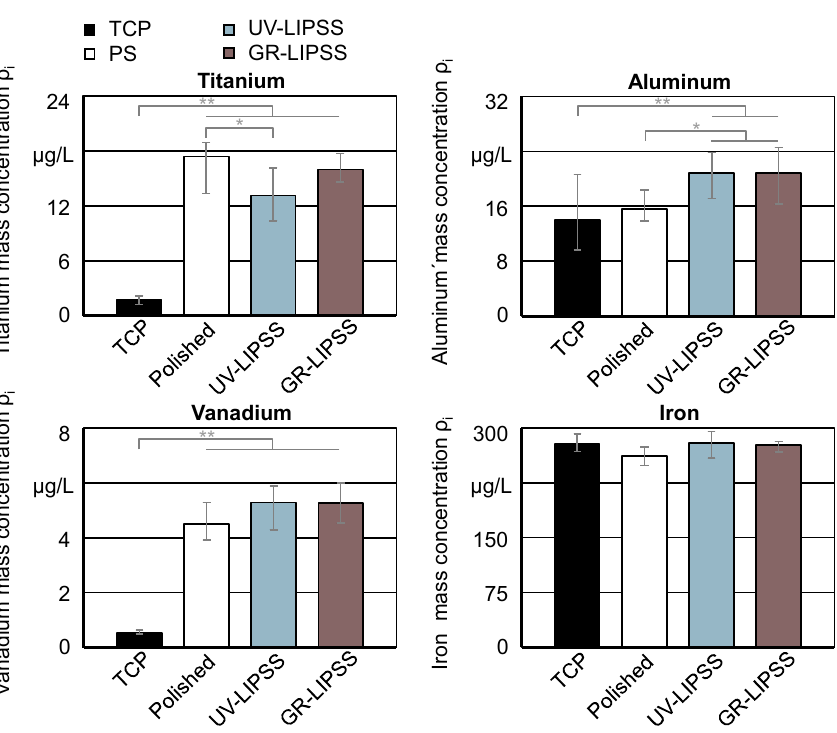
Figure 8. Metal release to supernatant on TCP, PO, UV-LIPSS, and GR-LIPSS after culture time t c = 8 days. Statistical analysis by ANOVA and Tukey’s test for determination of statistically significant differences (n = 5 each group, * for p < 0.05, ** for p < 0.01).